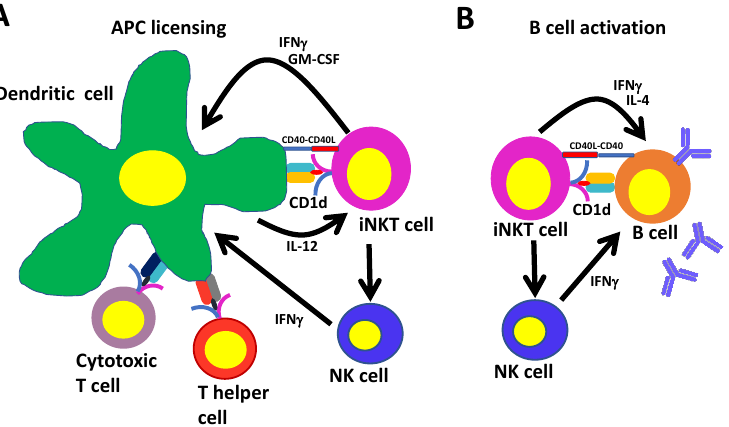
Figure 1. Universal T helper cell functions of invariant natural killer T (iNKT) cells. ( A ) iNKT cells mature and license dendritic cells when they recognize agonist-bound CD1d. iNKT cells upregulate CD40L and secrete interferon gamma (IFN γ ) and granulocyte-macrophage colony-stimulating factor (GM-CSF), which induces costimulatory molecule expression and the production of interleukin (IL)-12 by dendritic cells. This further stimulates iNKT cells and primes CD8 + T cells against copresented peptide epitopes. iNKT-conditioned dendritic cells promote conventional CD4 + T cell help to peptide antigens, which leads to additional enhancement of CD8 + T cell responses and promotes the generation of follicular T helper cells; ( B ) iNKT cells binding cognate antigen on CD1d-expressing B cells differentiate into iNKT follicular helper cells, which resemble conventional helper cells in their ability to augment B cell responses through a CD40–CD40L dependent mechanism. iNKT cells may also boost humoral immunity by transactivating NK cells that can stimulate B cells to secrete immunoglobulin G